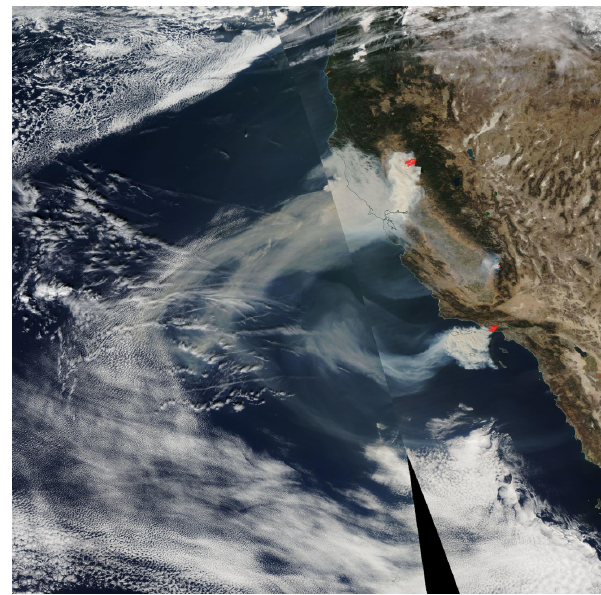
Figure A2. Smoke plume captured by Aqua MODIS for the Califor- nian fire event on 9 November 2018 (source: https://gibs.earthdata. nasa.gov, last access: 7 August 2019). The red regions indicate fires and thermal anomalies.